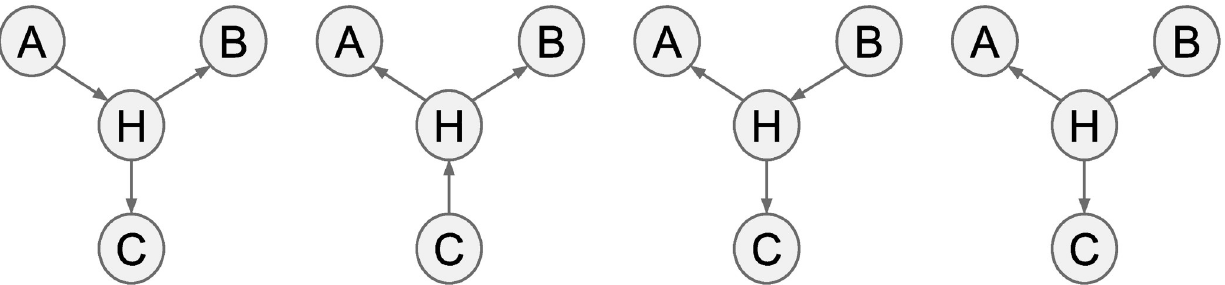
Fig 2. Visualizations of the four DAGs in G . H never has more than one incoming arrow.